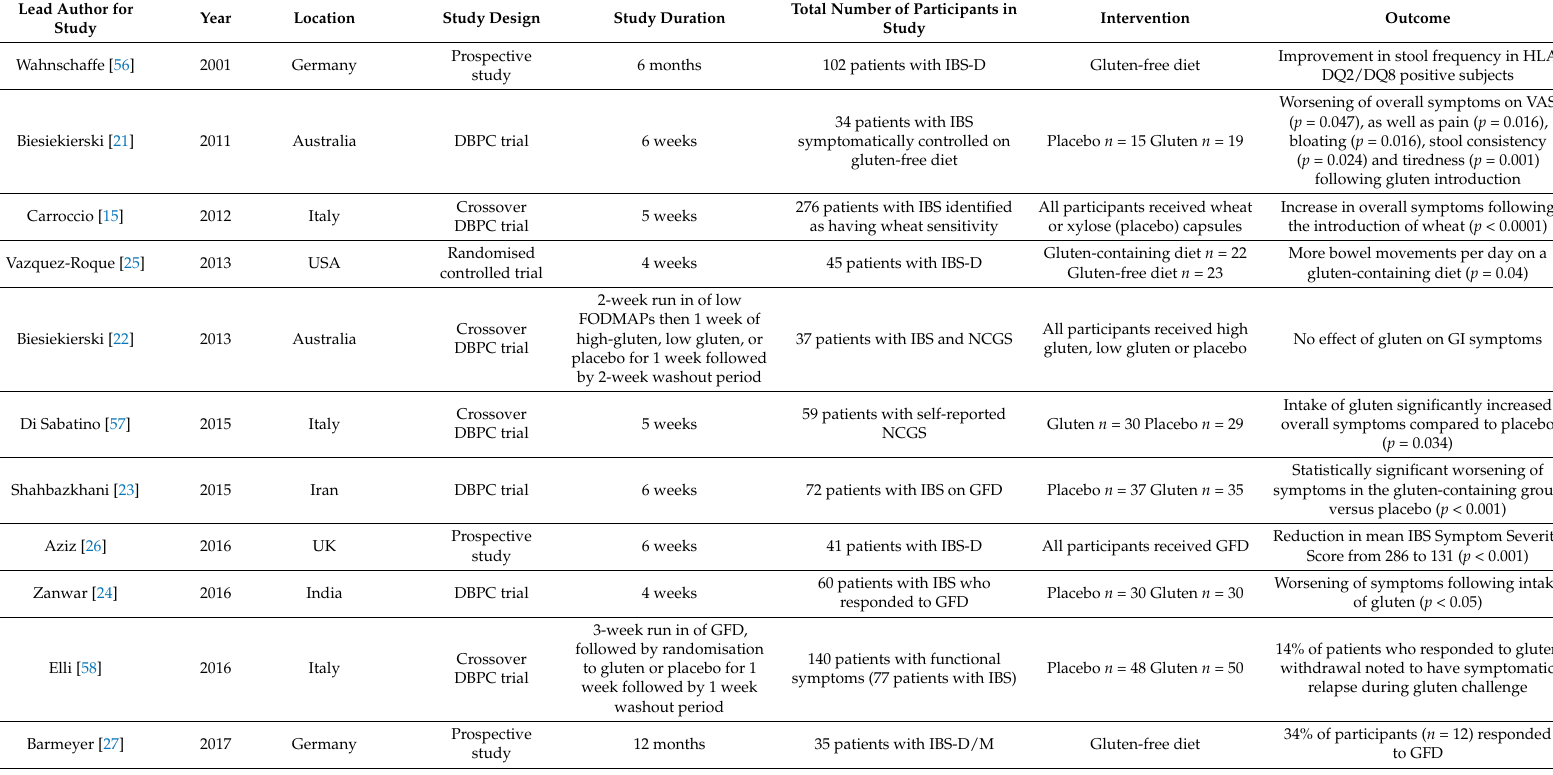
Table 1. The studies evaluating gluten and wheat in Irritable Bowel